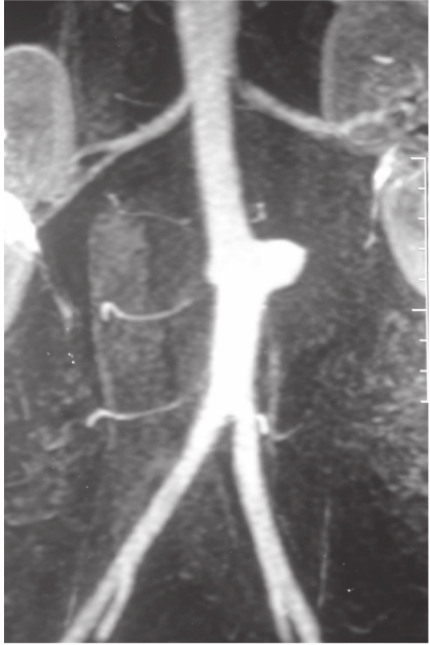
Figure 1 - Preoperative magnetic resonance angiography showing the aortic